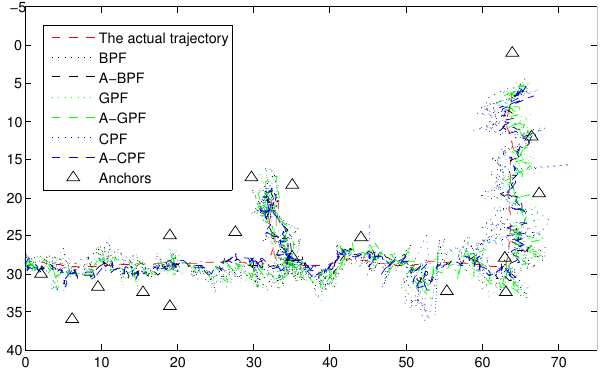
Figure 12. Trajectories for the indoor target tracking.